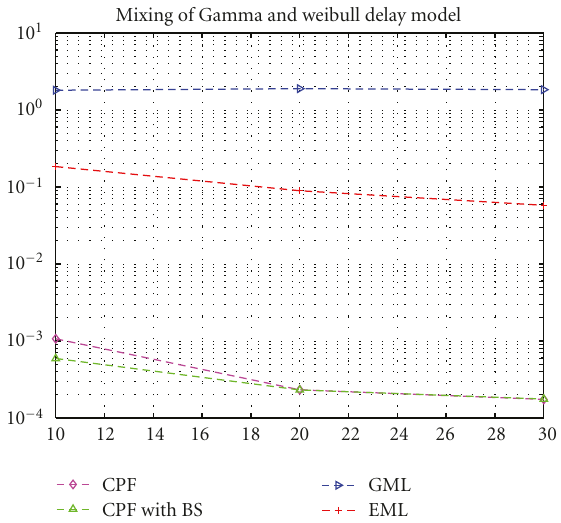
Figure 5: MSEs of clock o ff set estimators for mixing of Gamma [ α 1 = 2, β 1 = 5 and α 2 = 2, β 2 = 2] and Weibull [ α 1 = 2, β 1 = 2 and α 2 = 6, β 2 = 2].